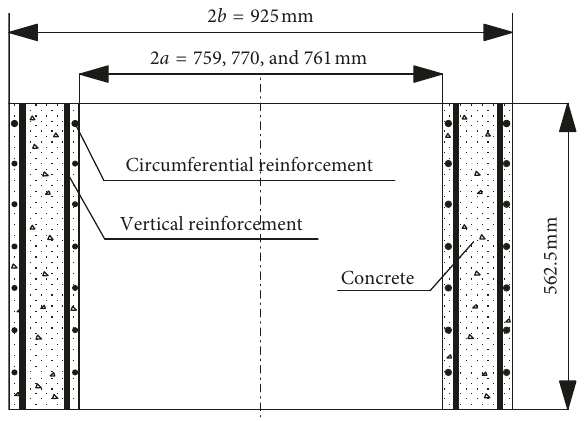
Figure 1: Shaft lining structure model (unit: mm).